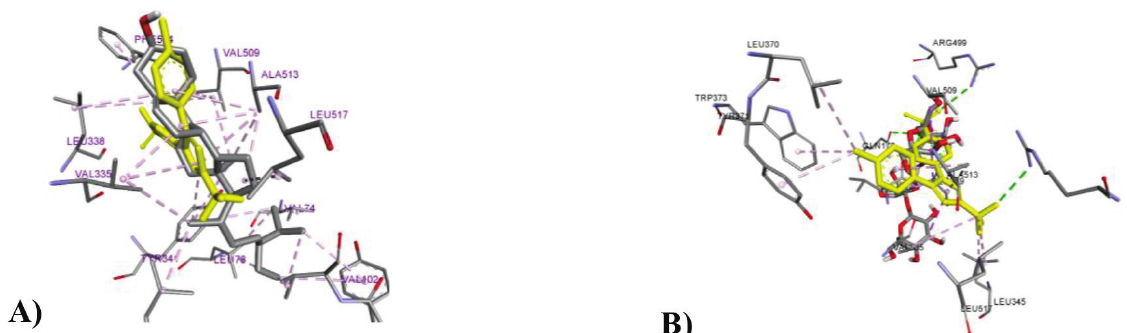
Figure 12. Visualization of the allocation into the COX-2 active site for celecoxib (yellow molecule) ( A ) sitosterine (grey molecule) and ( B )